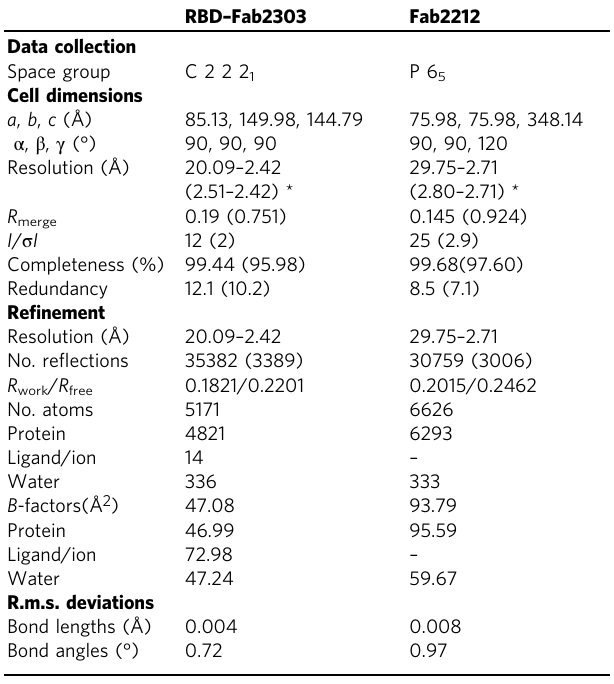
Table 1 X-ray Data collection and re fi nement statistics for RBD – Fab2303 complex and